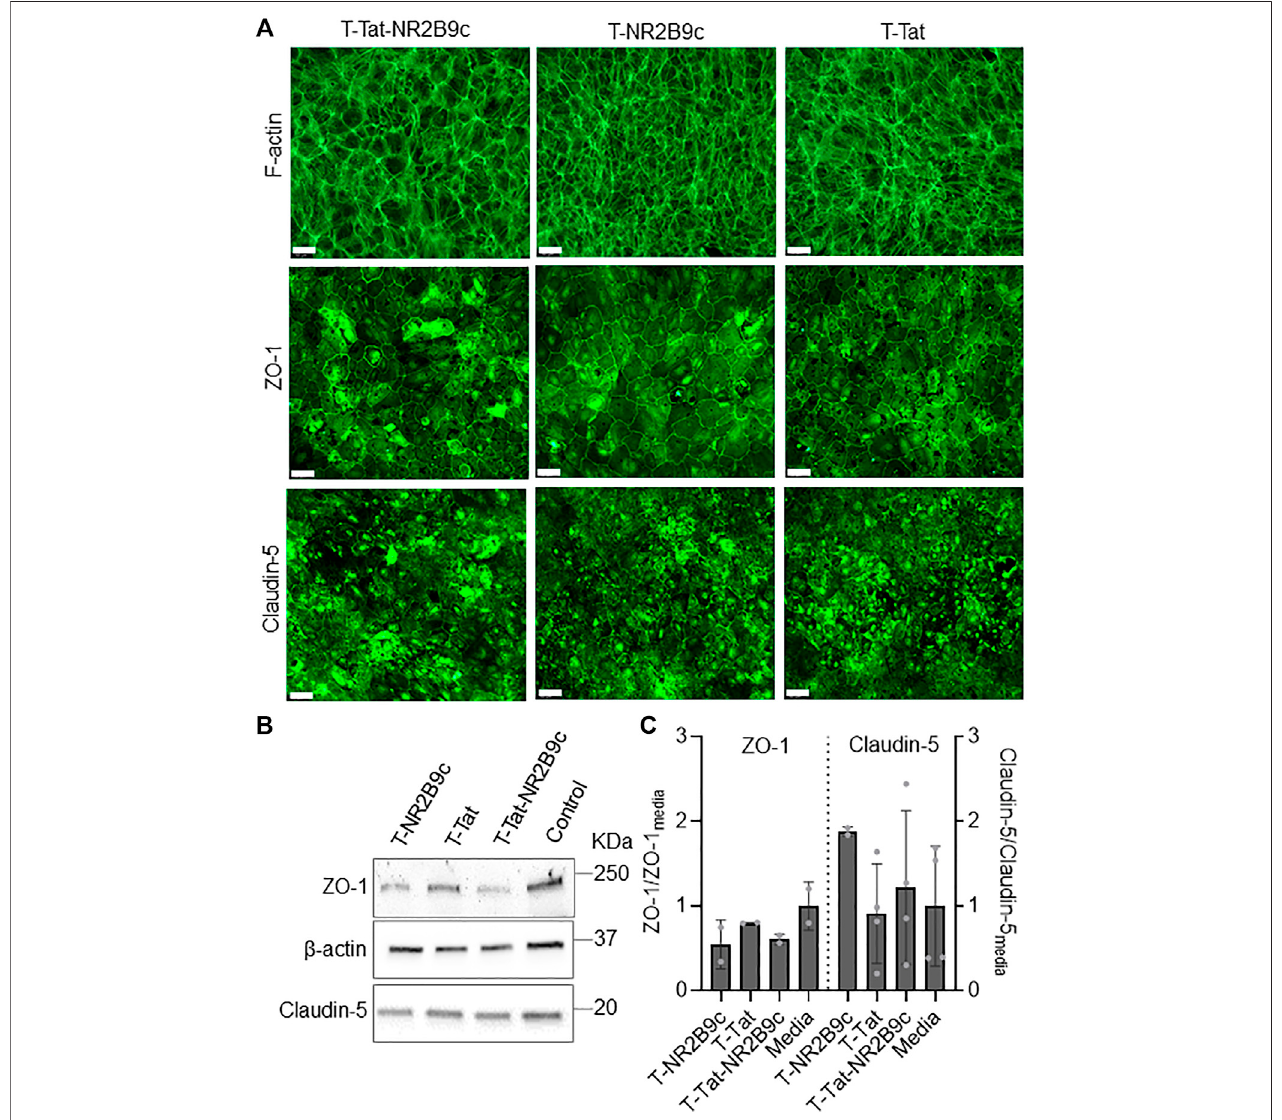
FIGURE5| Effects onactin,zonulaoccludens-1(ZO-1)and claudin-5expression inBIONi010-C monolayers after4-hincubationwithT-NR2B9c,T-Tat, orT-Tat- NR2B9cat37 ° C. (A) F-actinphalloidinstainingorzonulaoccludens-1(ZO-1)andclaudin-5immunostainingsimagedby fl uorescencemicroscopy.Scalebar:50 µm. (B) Detection of ZO-1, β -actin, and claudin-5 using Western blotting. (C) ZO-1 and claudin-5 expression were quanti fi ed relative to β -actin before ZO-1 and claudin-5 band intensities from the cells incubated with T-NR2B9c, T-Tat, or T-NA-1 were standardized against the medium control cells. Mean ± SD [ N = 2 (ZO-1), N = 2 – 4